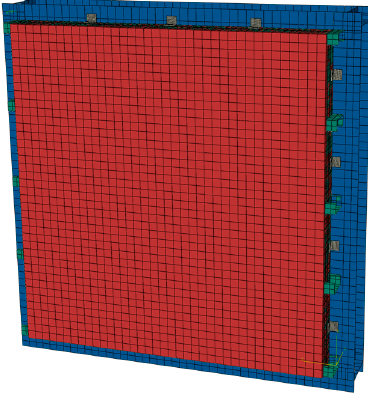
Figure 18. The finite element model.